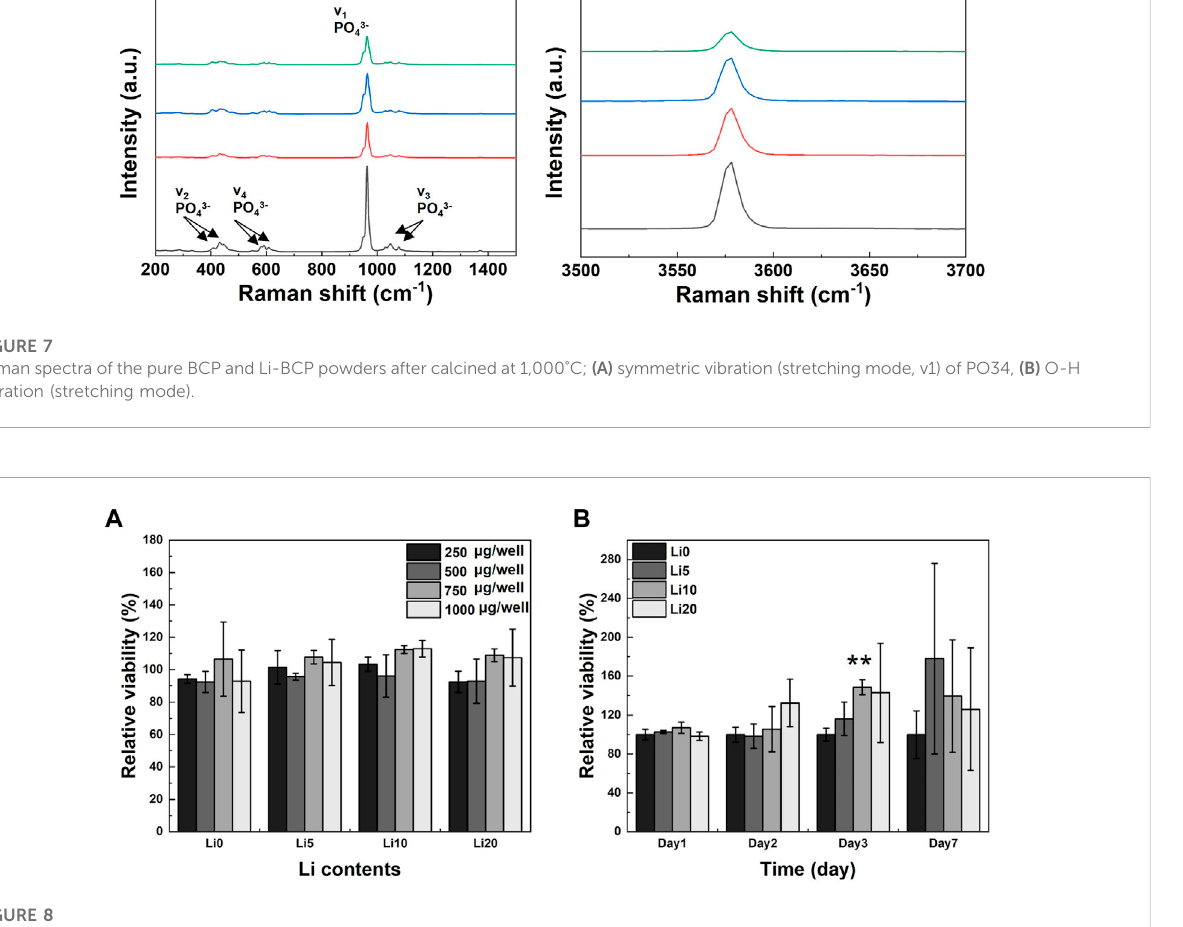
FIGURE 8 hDPSCs optical cell density on pure BCP and Li-BCP powders; (A) with different powder concentration for 1 day, and (B) with different culture times at 1,000 µg/well (vs. control). Asterisks indicate statistical signi fi cance (** p < 0.01) with respect to pure BCP at the same time point as determined by independent t -test.